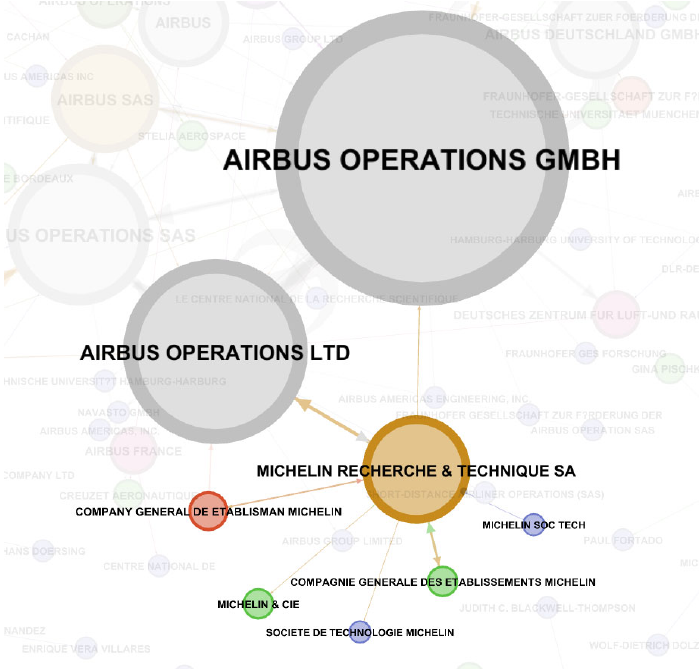
Figure 11. Network Analysis of Joint Research.